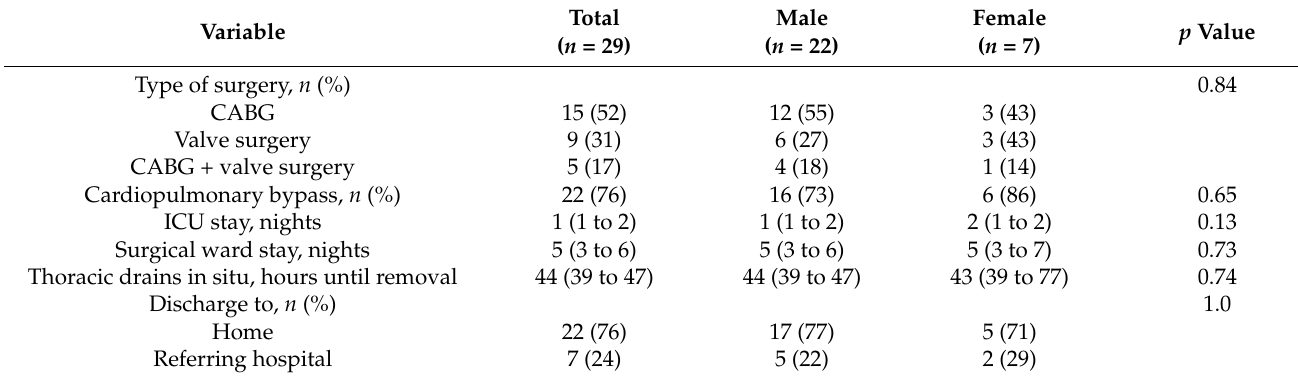
Table 3. Periprocedural and postoperative characteristics of the included patients.